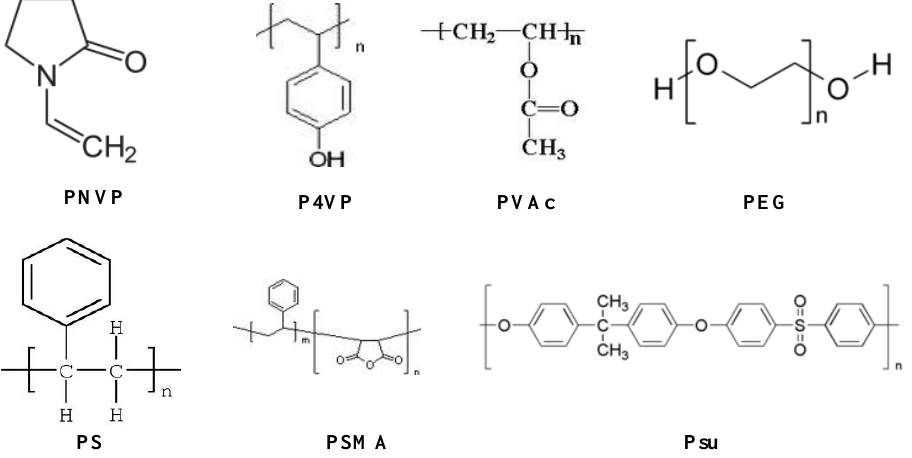
Figure 4. Seven polymer formulas selected as the sensitive